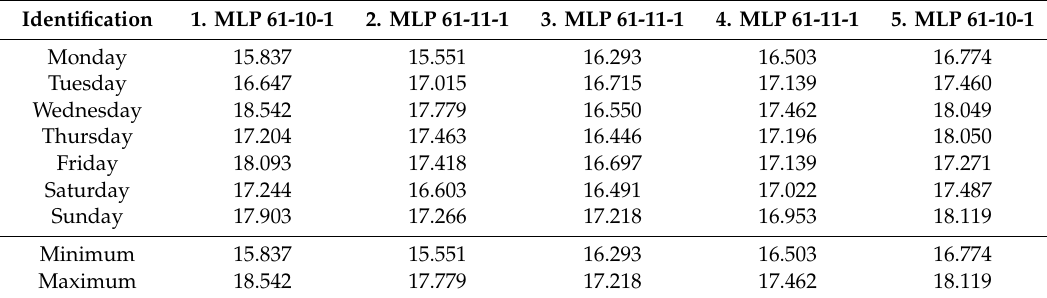
Table 12. Equalized time series absolute residuals—days of a